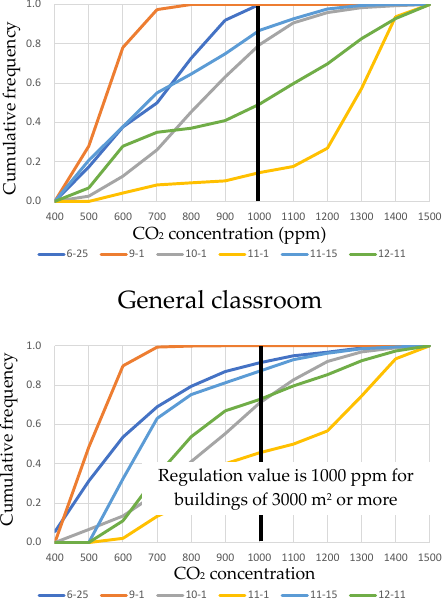
Figure 8. Cumulative frequency distribution of CO 2 concentration in special (mathematics) and general